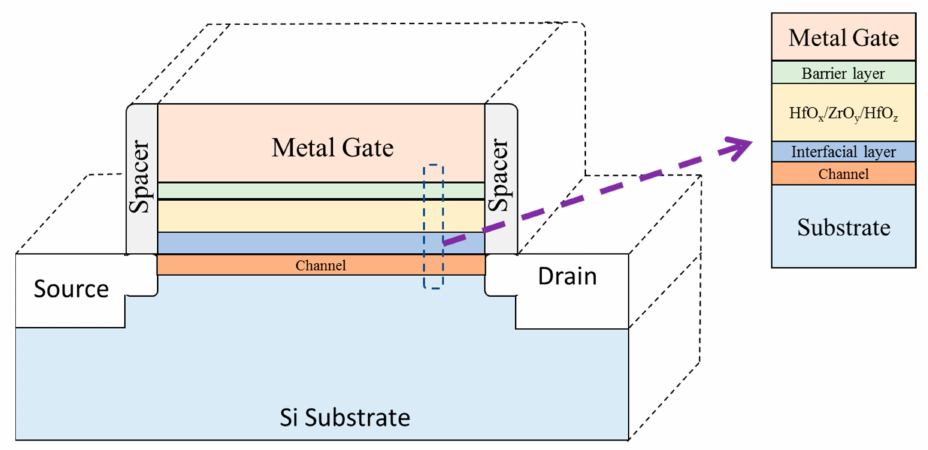
Figure 3. Schematic cross-section profile of an n-channel metal–oxide–semiconductor field-e ff ect transistor (n-MOSFET).